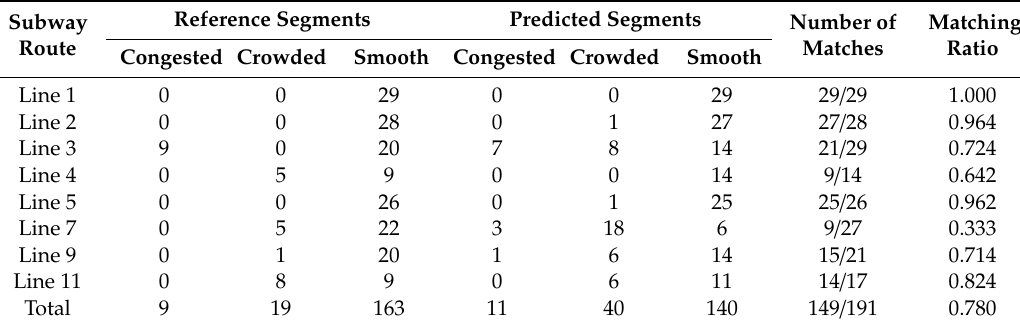
Figure 12. Comparison of reference and predicted congestion results for Line 3. Table 4. Comparison between actual and predicted